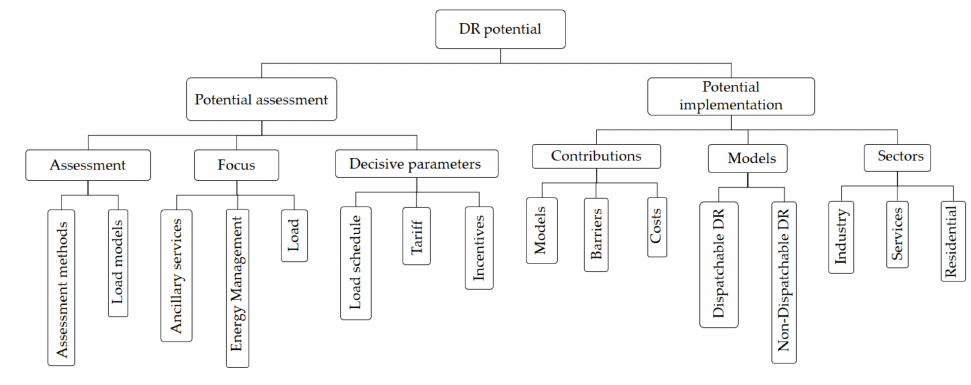
Figure 1. Architecture of the different areas of DR potential